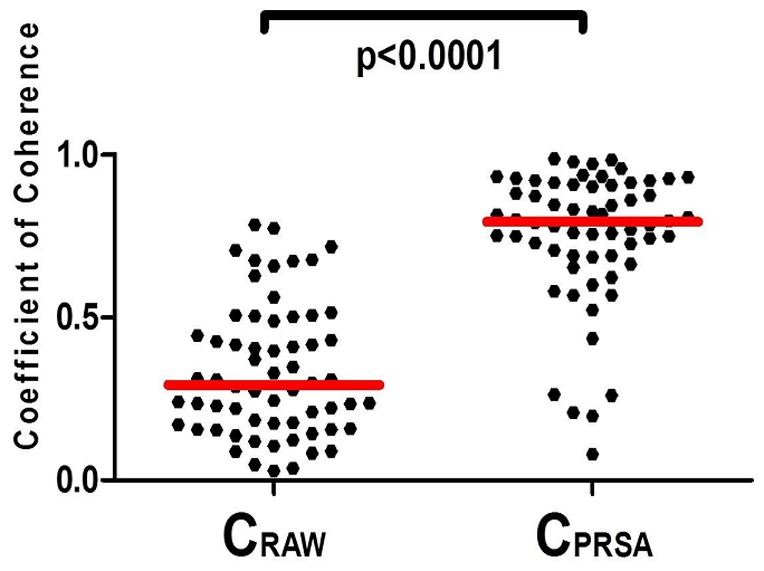
Comparison between coefficients of coherenceprovided by conventional cross-spectral analysis (CRAW, median 0.29, interquartile range 0.17–0.49) and by bivariate Phase-Rectified Signal Averaging (CPRSA median 0.79, interquartile range 0.69–0.91); p<0.0001.